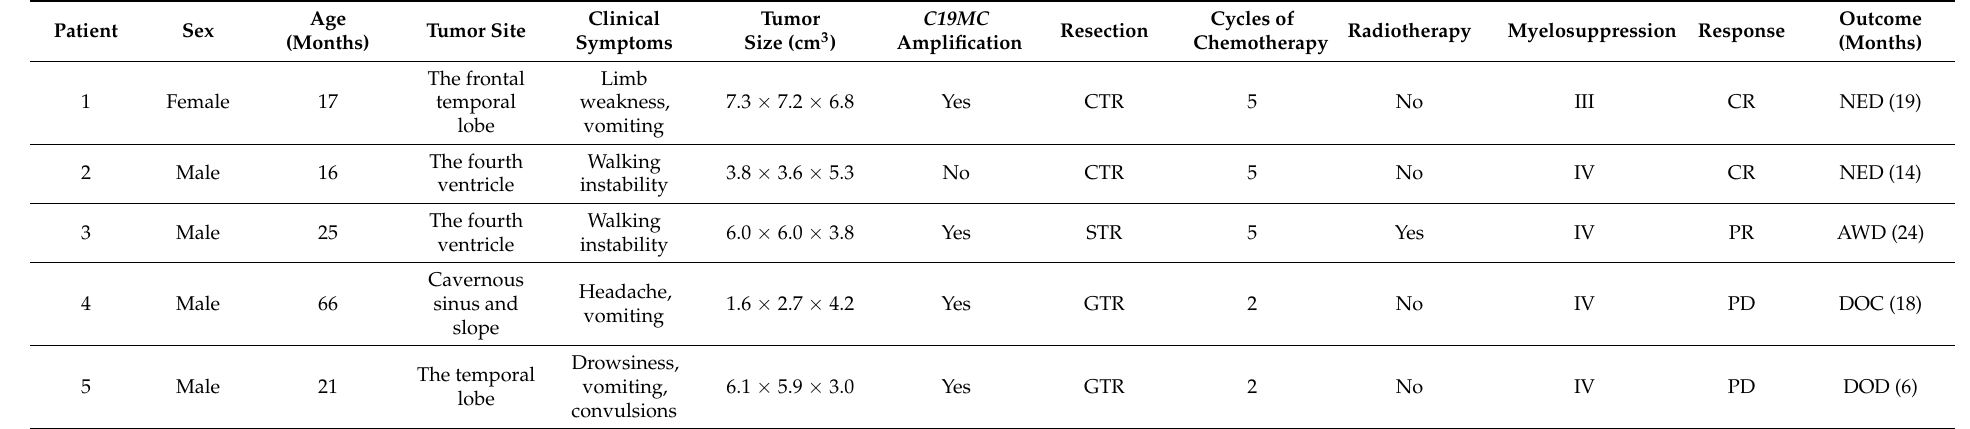
Table 2. Clinical characteristics of children with an